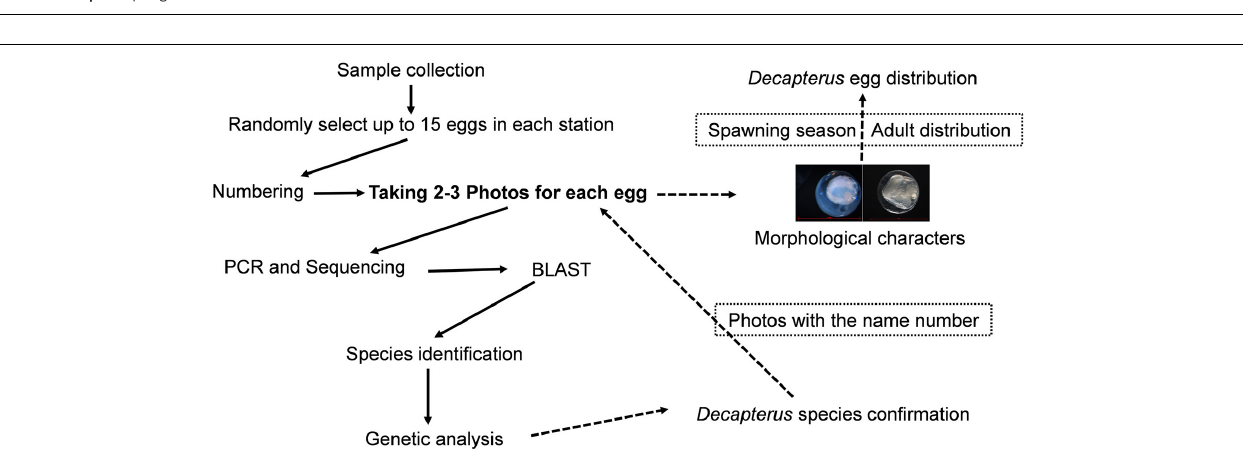
FIGURE 1 | Sampling location in the northern South China Sea.